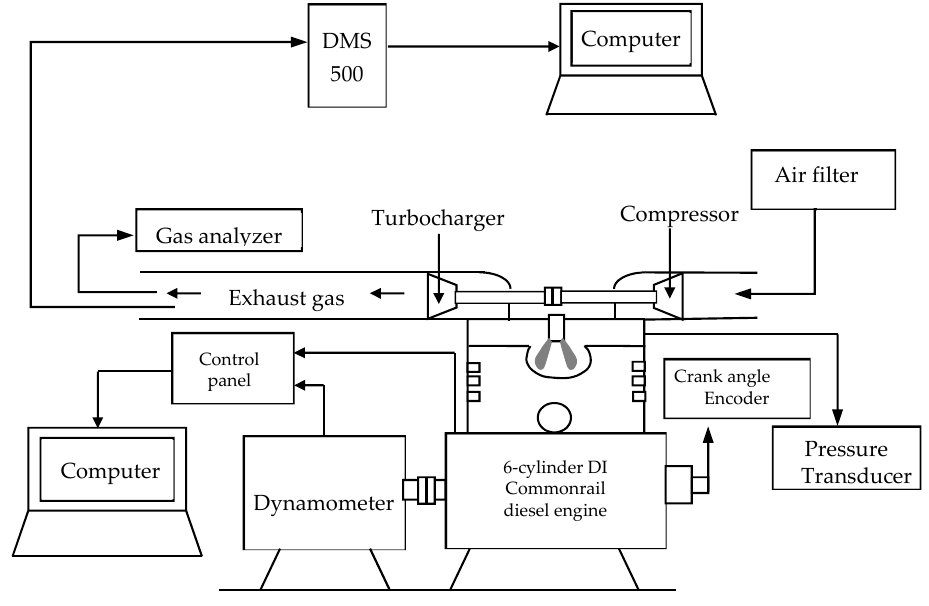
Figure 1. Schematic diagram of the experimental set up [17].